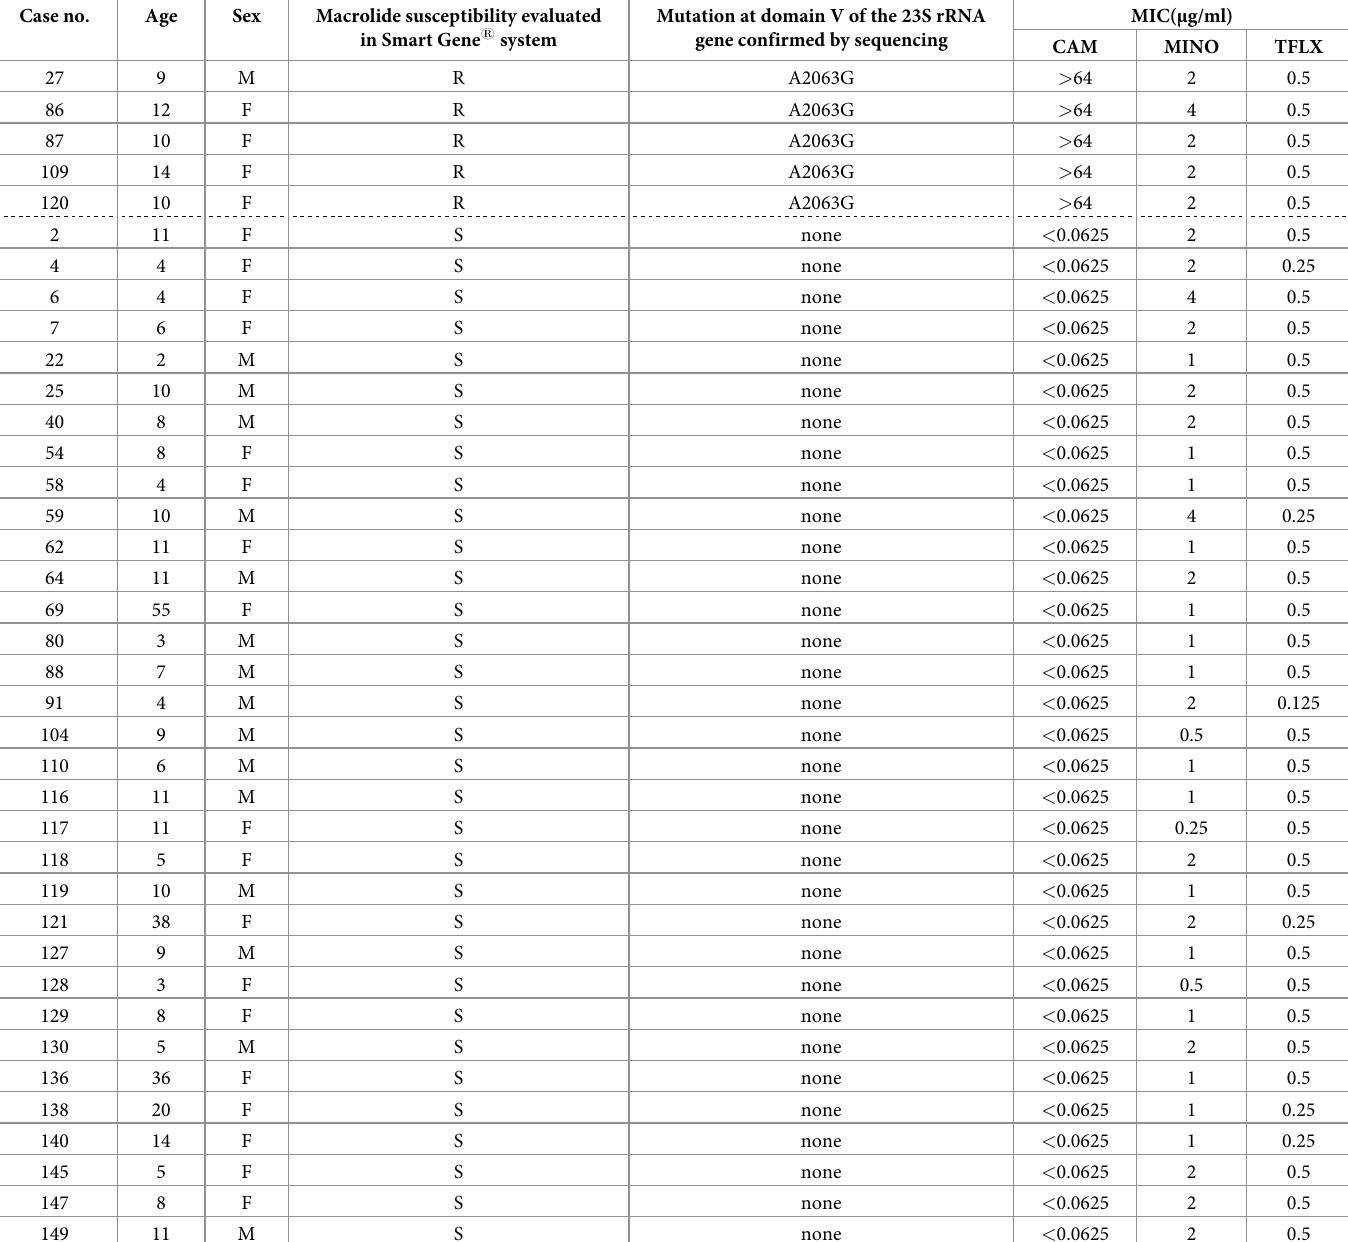
Table 2. Macrolide susceptibility evaluated in the Smart Gene 1 system and MICs of antibiotics among M . pneumoniae isolates. Case